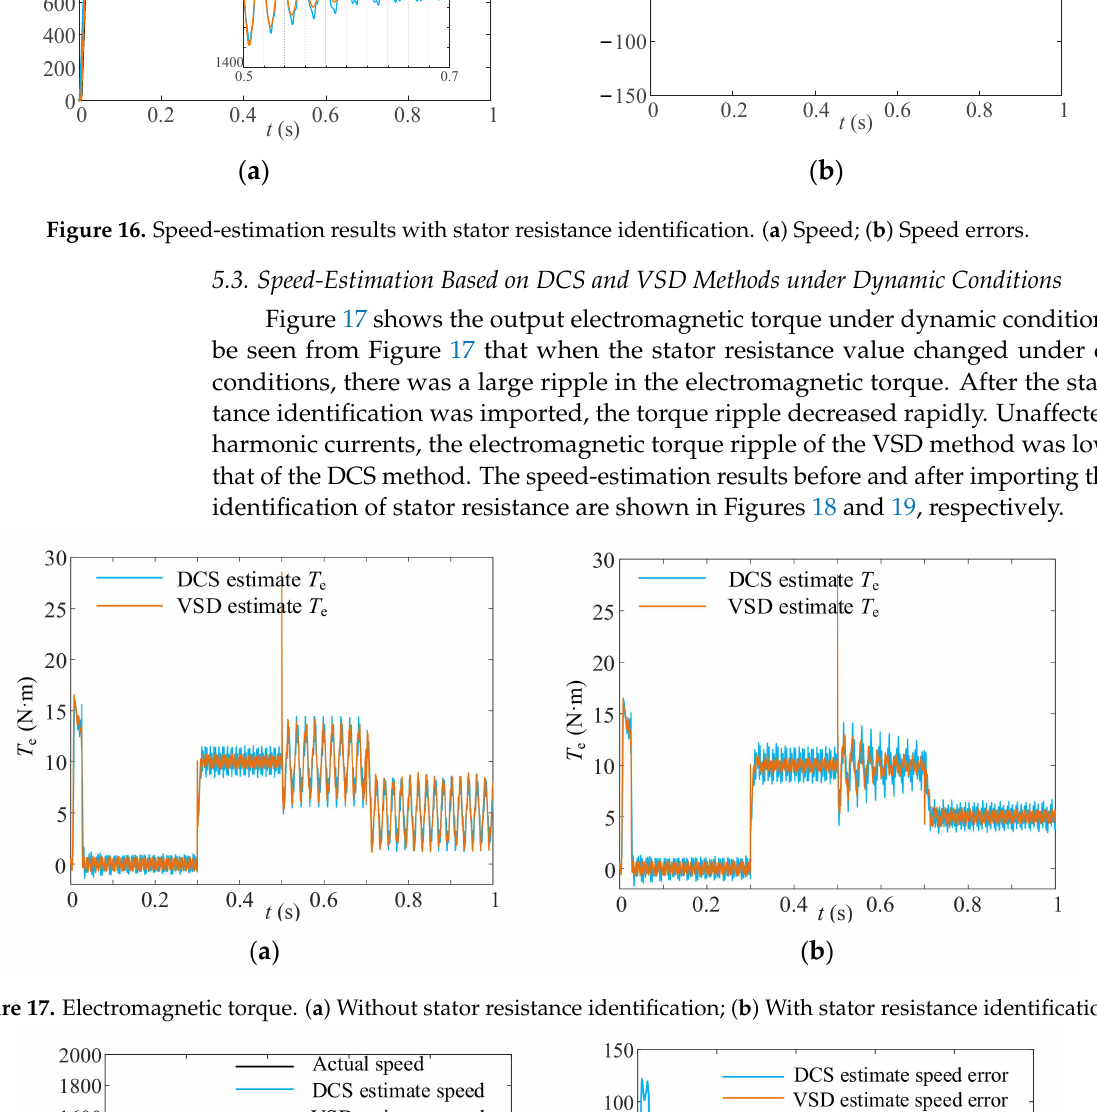
Figure 16. Speed-estimation results with stator resistance identification. ( a ) Speed; ( b ) Speed errors.